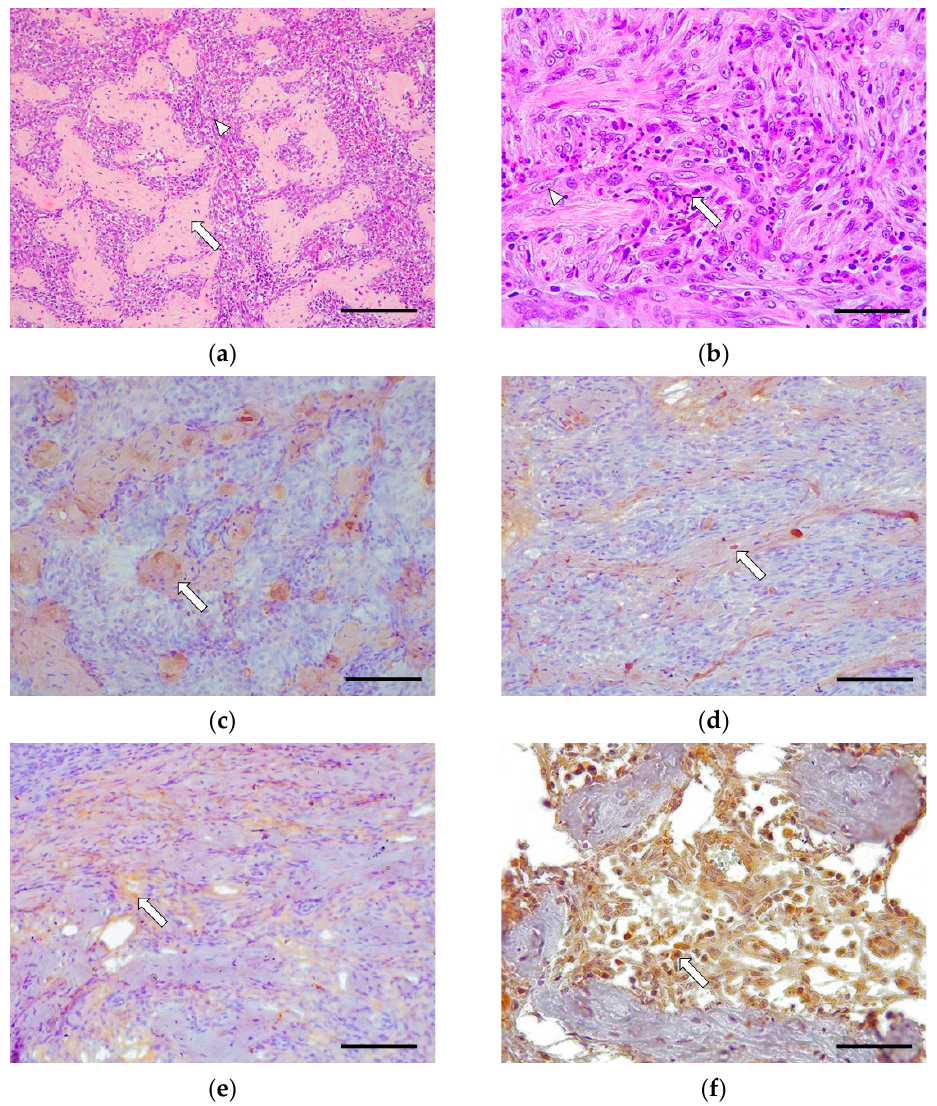
Figure 2. Feline Eosinophilic Gastrointestinal Sclerosing Fibroplasia (Grade II). Cat, duodenum, case No. 13. ( a ) Abundant collagen bands (arrow) surround a large number of proliferating fibroblasts and eosinophils (arrowhead). Hematoxylin–eosin. Scale bar: 400 µ m ( b ) Large number of proliferating fibroblasts (arrowhead) and eosinophils (arrow). Hematoxylin–eosin. Scale bar: 100 µ m. ( c ) Moderate fibrillar collagen I immunoexpression is observed in the collagen bands large number of proliferating fibroblasts and eosinophils (arrow), located at the level of the submucosa and muscular layers. Rabbit polyclonal anti-collagen I. Scale bar: 200 µ m. ( d ) Moderate collagen III immunoexpression in the collagen bands and around the fibroblasts (arrow), located in the submucosa and the muscular layers. Rabbit polyclonal anti-collagen III. Scale bar: 200 µ m. ( e ) Moderate diffuse immunoexpression is observed around proliferating fibroblasts (arrow) in the submucosa and the muscular layers. Rabbit polyclonal anti-fibronectin. Scale bar: 200 µ m. ( f ) Intense diffuse TGF- β 1 cytoplasmic immunoexpression in fibroblasts and mononuclear cells between the collagen bands (arrow), in the submucosa, and muscular layers. Rabbit polyclonal anti-TGF- β 1. Scale bar: 100 µ